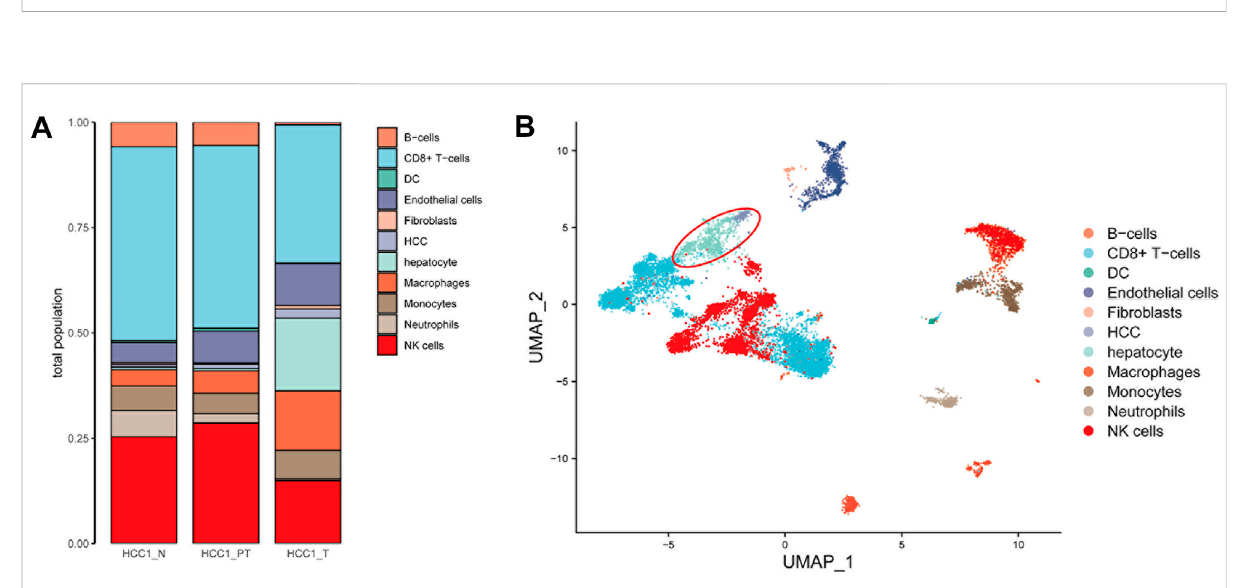
FIGURE 2 Annotation of different cell types in HCC tissues. (A) Number of 11 cell types in HCC tissues was calculated and shown with a bar plot; and (B) distribution of the cell type in the UMAP plot (liver cells are in the red circle, including hepatocytes and hepatocellular carcinoma